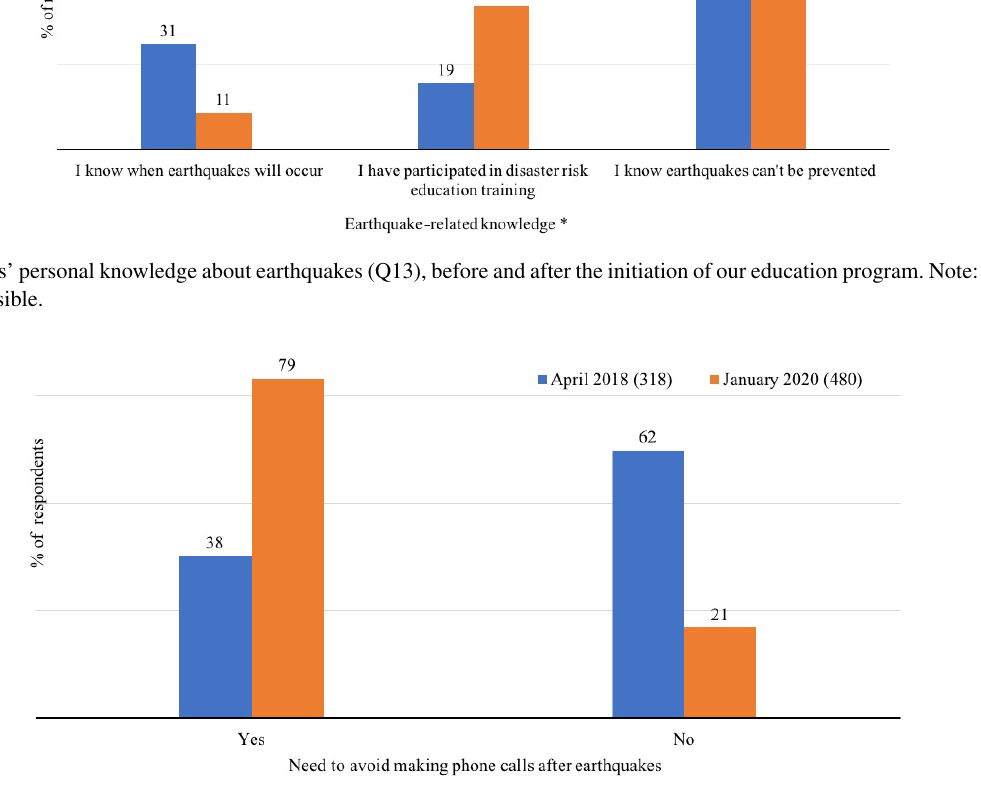
Figure 8. Student’s knowledge on the recommendation to avoid making phone calls after an earthquake to leave lines available for rescue operations (Q6), before and after the initiation of our education program. ( χ 2 = 138 . 72 and p value = < 0 . 00001; the change is